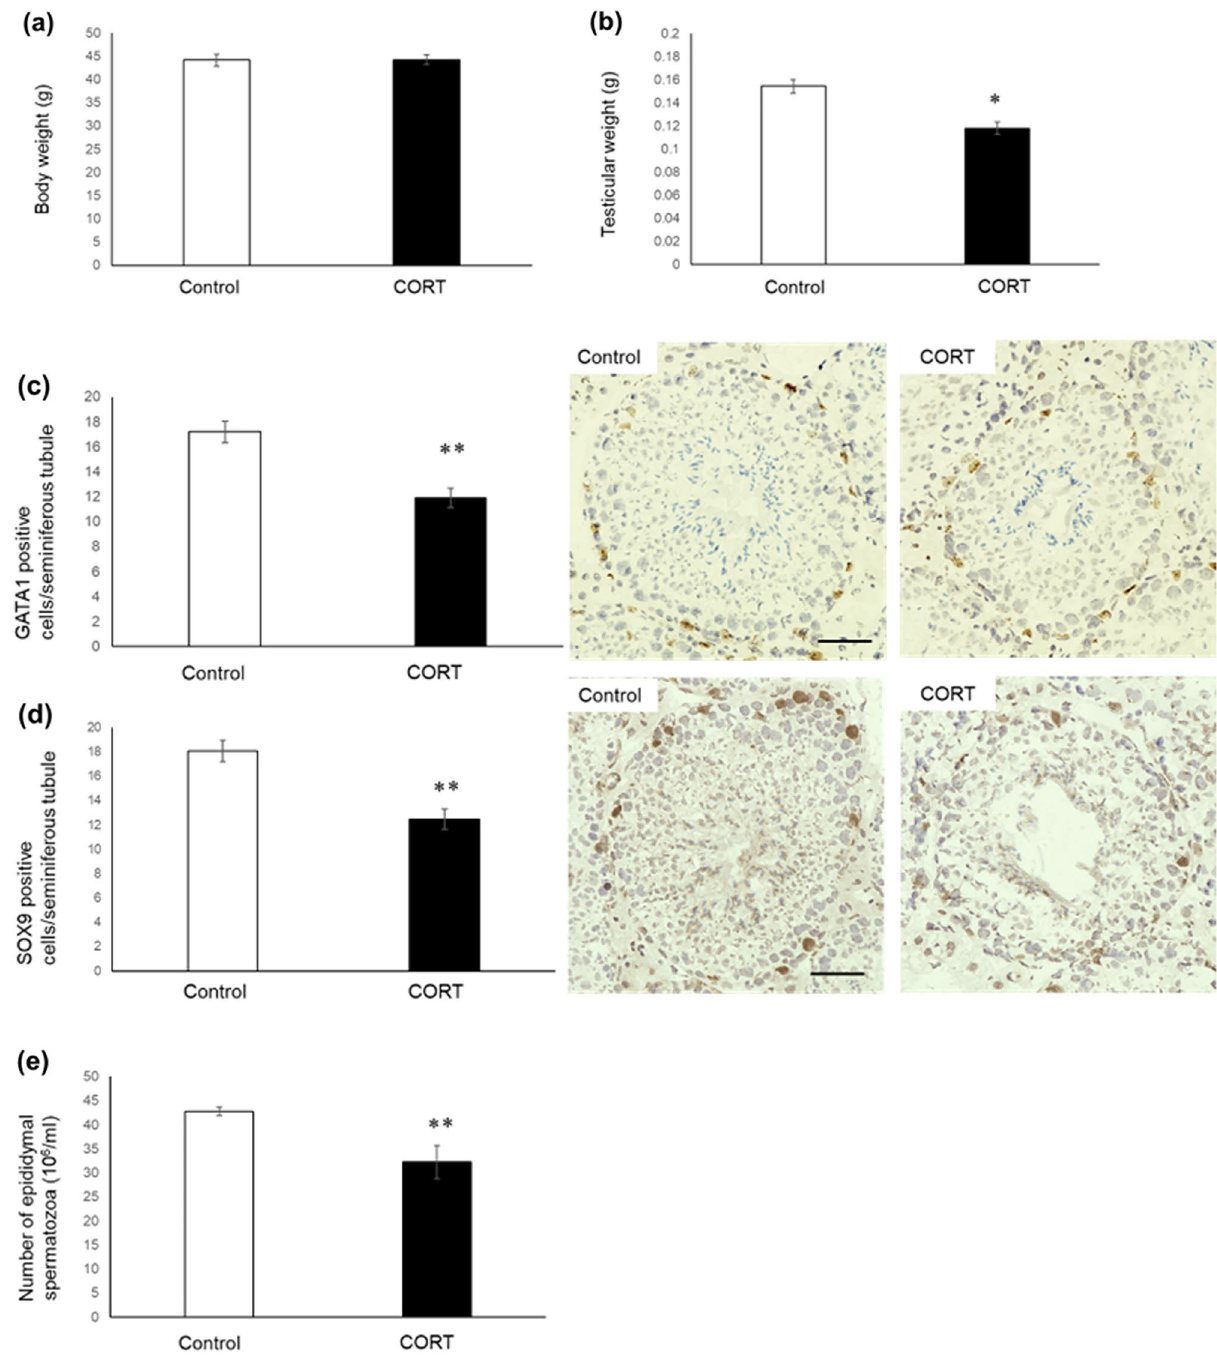
Figure 11. Testicular weight, Sertoli cell number, and spermatozoa count in CORT-administered mice on PND 70. Body weight ( a ), testicular weight ( b ), GATA-1-positive cells per seminiferous tubule ( c ), SOX-9- positive cells per seminiferous tubule ( d ), and spermatozoa count ( e ) on PND 70 were investigated between control and low-dosed-CORT mice. The scale bar is 50 µm. Values are expressed as the mean ± S.E.M of 12 samples per group for body weight, testicular weight, and spermatozoa count. For GATA-1-positive cells, values are expressed as the mean ± S.E.M of data from 10 animals per group (10 seminiferous tubules per animal). *p < 0.05, **p < 0.01 compared to the